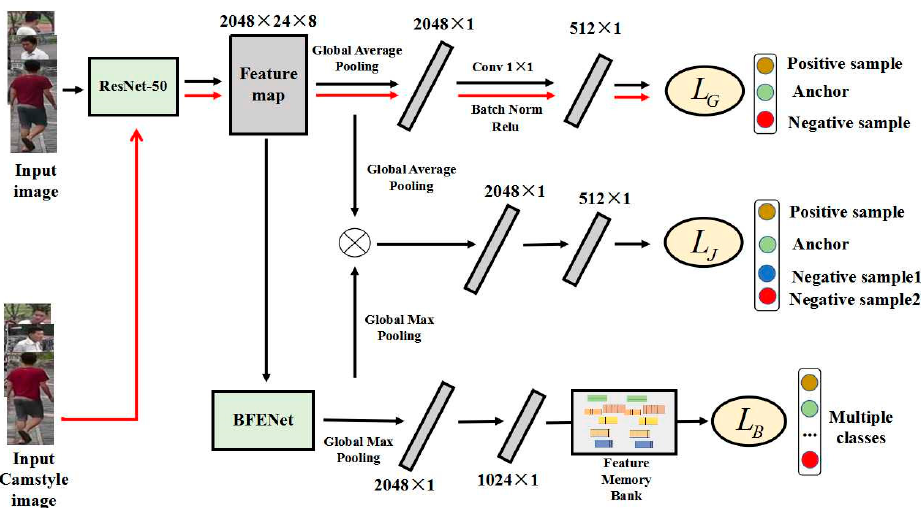
Figure 2. The structure of our unsupervised Cross-camera Erased Feature Learning (CEFL) network. In the three branches from top to bottom, we used three different components and loss functions. Features is classified by minimizing intra-class gaps while maximizing inter-class gaps in cross-camera global feature learning. Similar erased feature vectors are pulled together and dissimilar features are pushed away in erased partial feature learning. Global features and erased features are used together in joint global and partial feature learning.